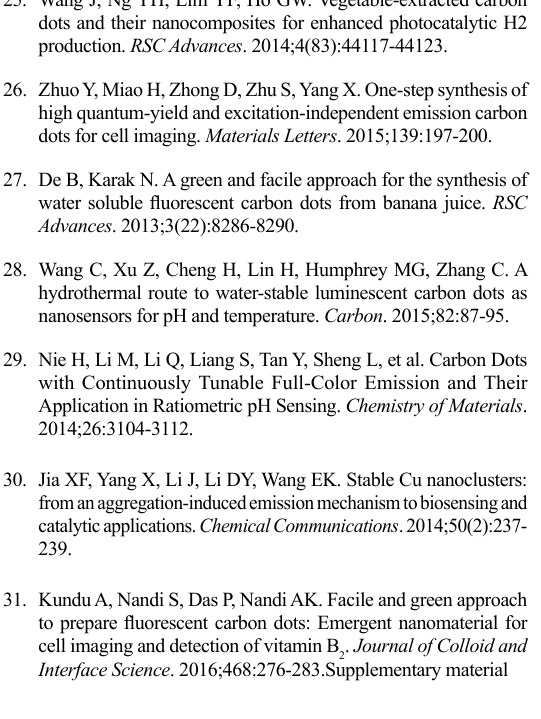
Figure S1. UV-vis spectra of of C-dots solution obtained at different reaction times of hydrothermal treatment: (a) 6, (b) 12, (c) 18 and (d) 24 h. Temperature of hydrothermal treatment used was 160 °C. Figure S2. Room temperature PL spectra of C-dots solution obtained at different reaction times of hydrothermal treatment: (a) 6, (b) 12, (c) 18 and (d) 24 h. Temperature of hydrothermal treatment used was 160 °C. Figure S3. UV-vis spectra of of C-dots solution obtained at different temperatures of hydrothermal treatment. Reaction time of hydrothermal treatment used was 18 h. Figure S4. Digital photographic images of C-dots obtained at several reaction times: (a) 6, (b) 12, (c) 18 and (24) h. Temperature of hydrothermal treatment used was 160 °C. Figure S5. Composite films based on C-dots with PVA polymer (C-dots/PVA-2) (a) under visible and (b) UV lights. Figure S6. C-dots/PVA-2 composite film in the absence and presence of Fe 3+ ions: images have been taken under (A) visible light and (B) UV